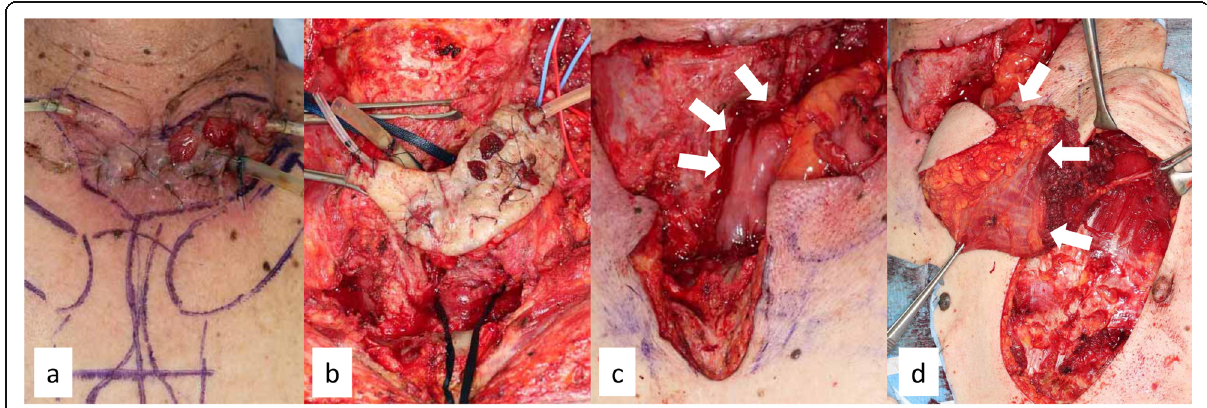
Fig. 1 a Refractory anastomotic fistula was observed on the 60th day after esophagectomy. b Debridement of the necrotized tissues was performed. c Salvage reconstruction with the free jejunal autograft (arrows) was performed. The jejunal artery and vein were anastomosed to the right transverse cervical artery and the right internal jugular vein, respectively. d The pectoralis major muscle flap (arrows) was used. These figures have been previously published (Umezawa H. Treatment of infections in the head, neck and facial area. PEPARS. 2017;